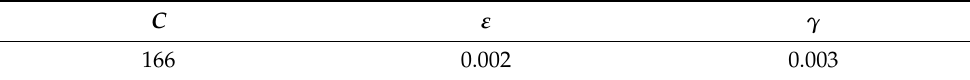
Table 5. Results of the hyper-parameter tuning based on Bayesian